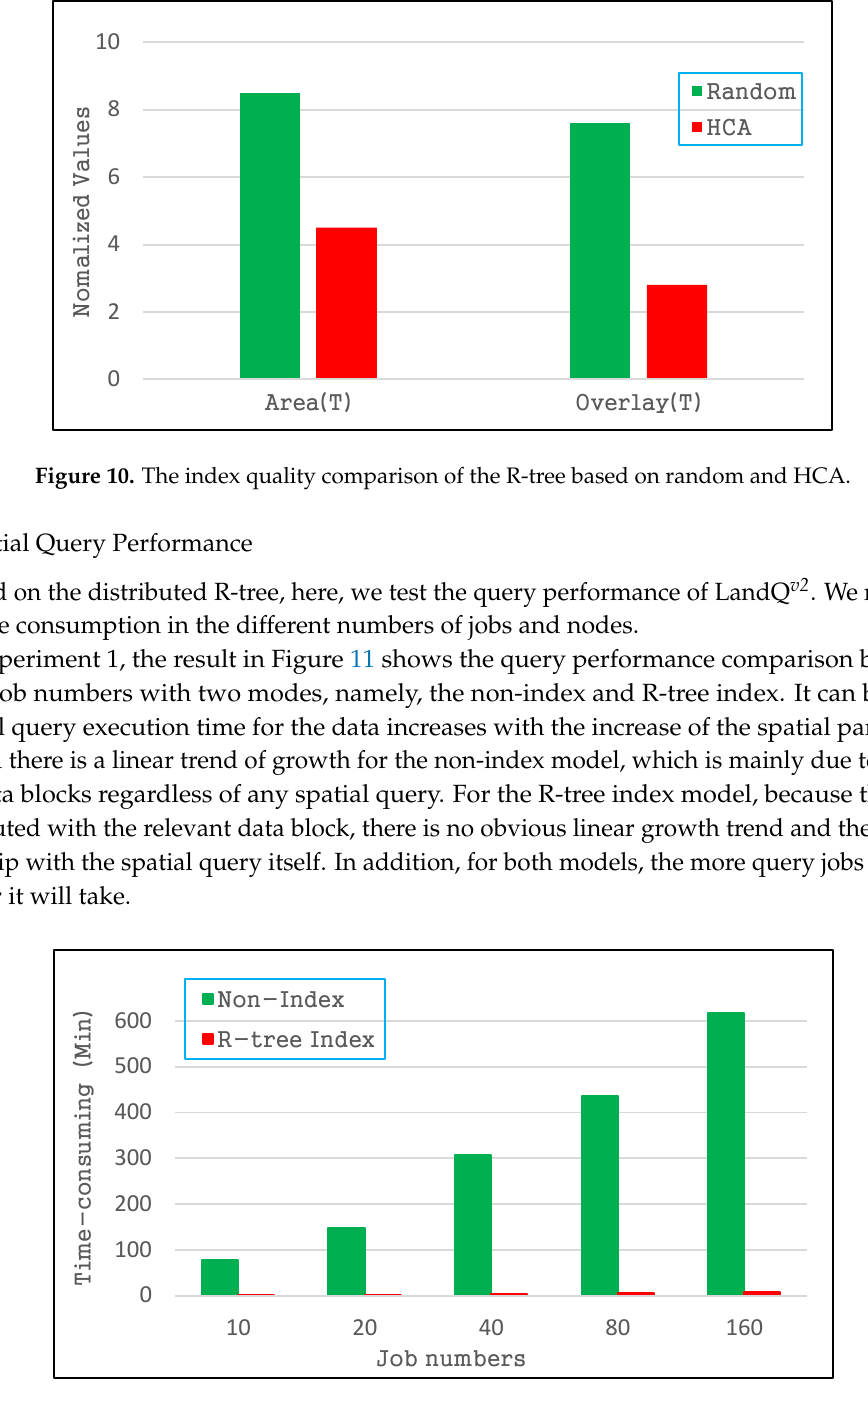
Figure 11. The query performance comparison between the different job numbers. Experiment 2 tests the vector data query efficiencies with spatial index in different cluster nodes.